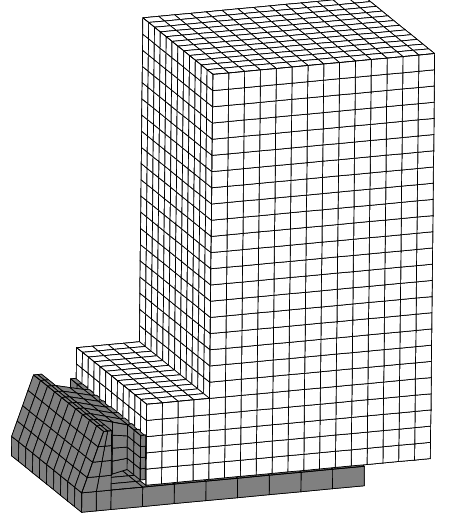
Fig. 1. Simple box model on a deceleration sled representing curb-tripped rollover